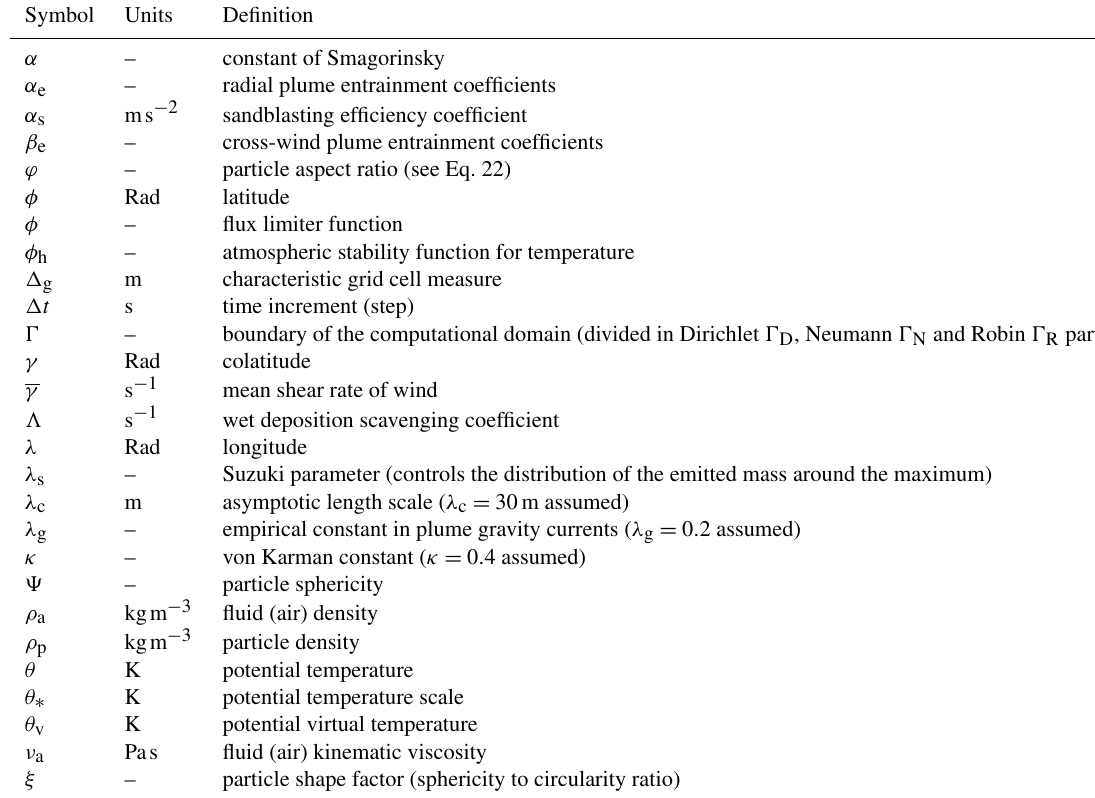
Table 2. List of Greek symbols.